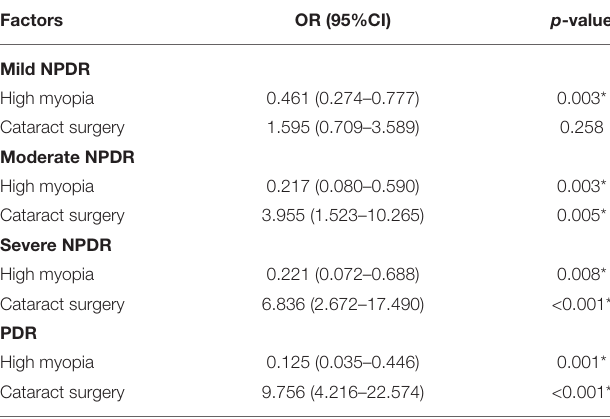
TABLE 3 | Analysis of risk factors in different stages of